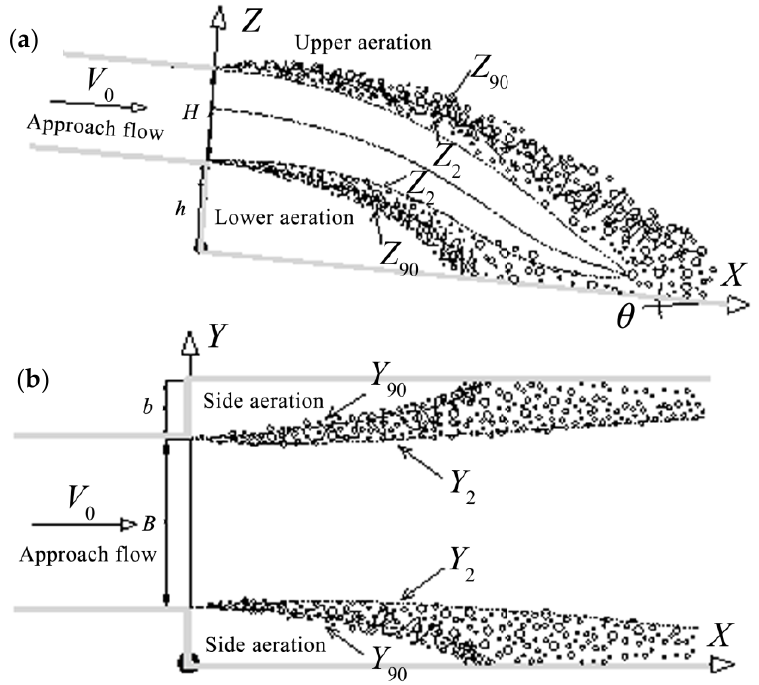
Figure 2. Schematic with the relevant parameters: ( a ) side view and ( b ) plan view.